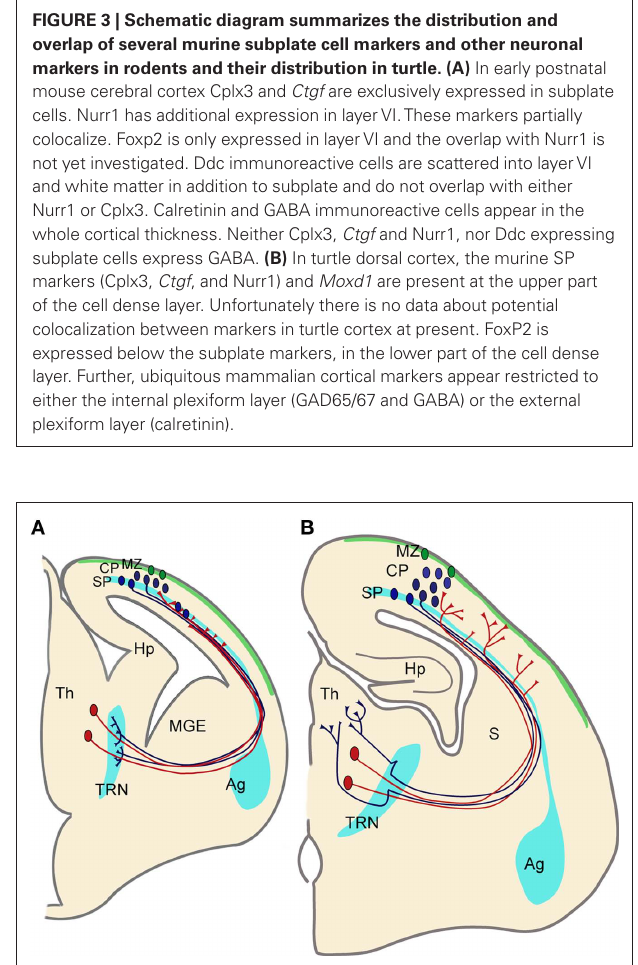
Figure 4 | Functional correlation between the developing thalamo- cortical projections, cortical SP zone, and thalamic reticular nucleus. (A) Corticofugal (blue) and thalamo-cortical (red) axons extend toward each other at early stages during embryonic development and reach close to their targets. However they both stop short of their ultimate targets and corticofugal projections from subplate and layer VI accumulate in the thalamic reticular nucleus (TRN) and thalamo-cortical projections in subplate, respectively. Both compartments contain largely transient cells that get integrated into circuits during these early stages. (B) Toward the middle of the first postnatal week corticofugal and corticopetal axons enter the thalamus (Th) and cortical plate (CP), respectively, where they arborize and establish their contacts with their ultimate targets in thalamus and neocortex. There are signs of fiber decussations in the TRN and in the subplate indicating some rearrangements during development. Pale blue areas (amygdala, subplate, and thalamic reticular nucleus) represent brain regions sharing gene expression patterns. Ag, amygdala; Hp, hippocampus; MGE, medial ganglionic eminence; MZ, marginal zone (green area);